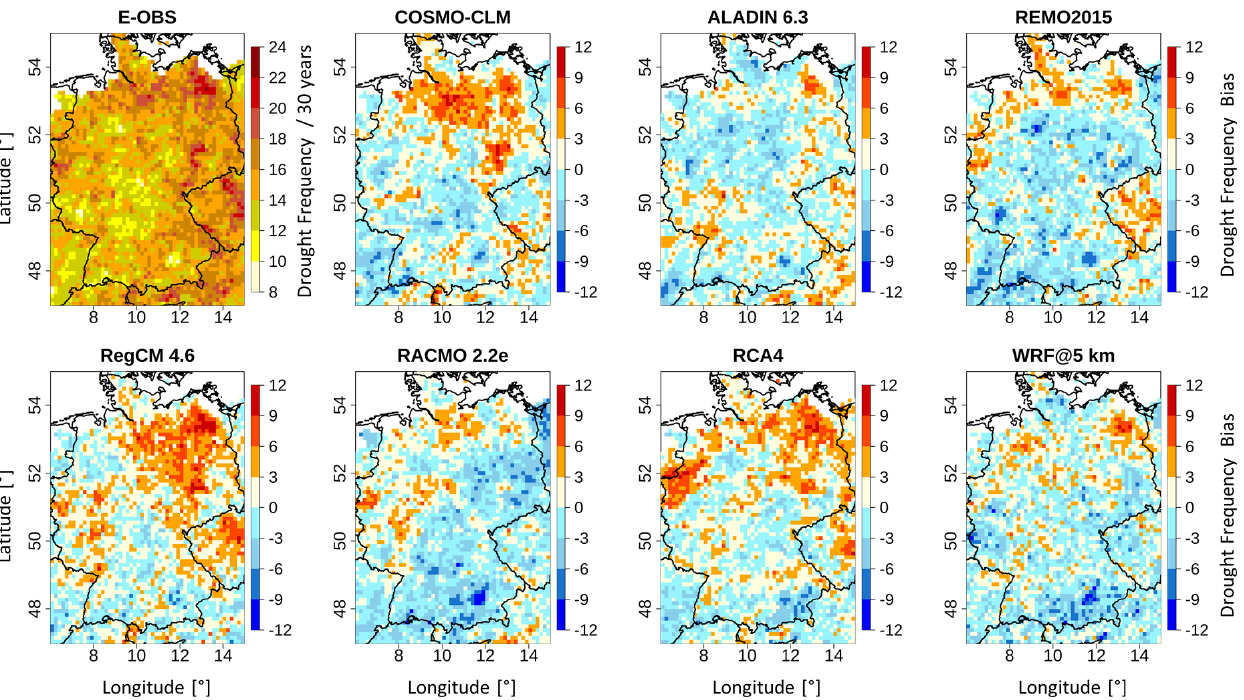
Figure 6. Grid-cell-based E-OBS drought frequency pattern based on SPEI-3 between 1980–2009 and differences between each RCM and E-OBS.